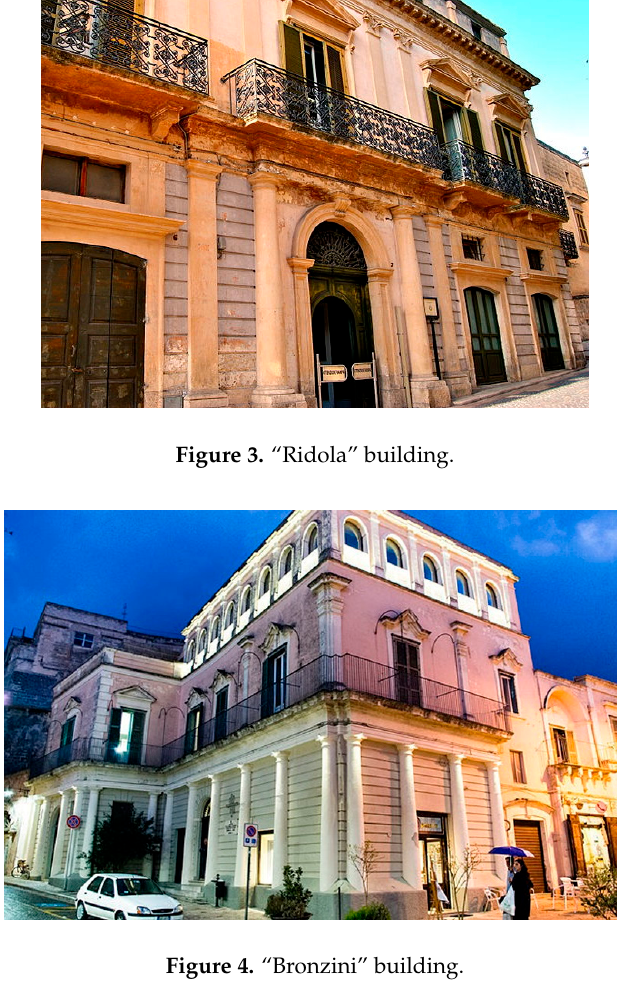
Figure 4. “Bronzini” building.